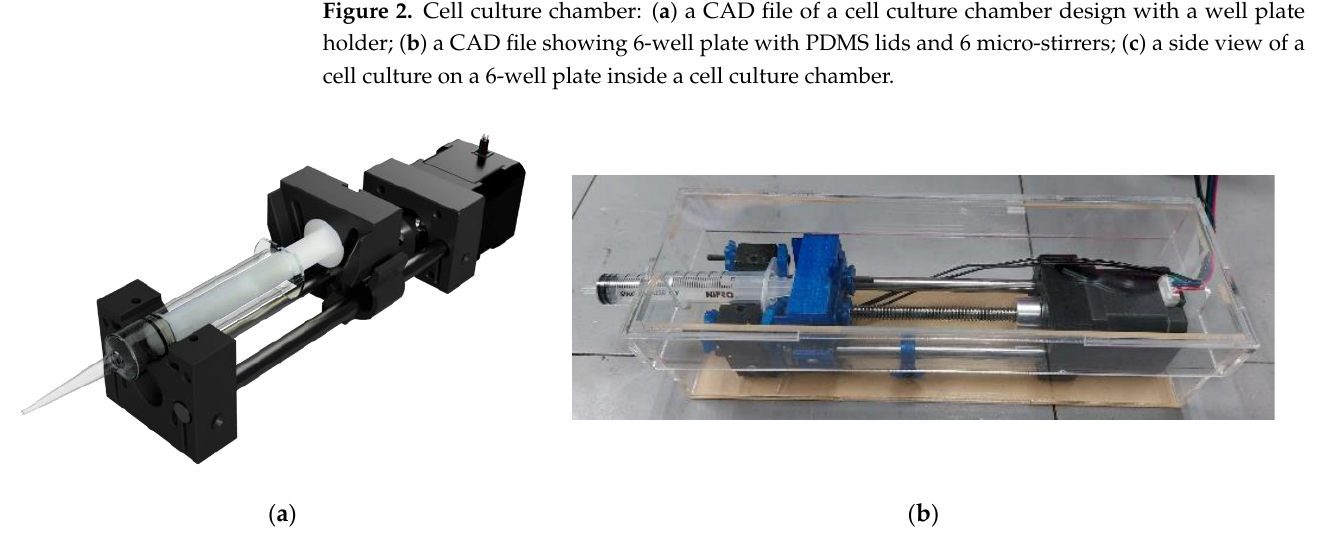
Figure 3. Syringe pump: ( a ) a CAD file of syringe pump design; ( b ) a photo of syringe pump with a 10-mL syringe in an acrylic box.